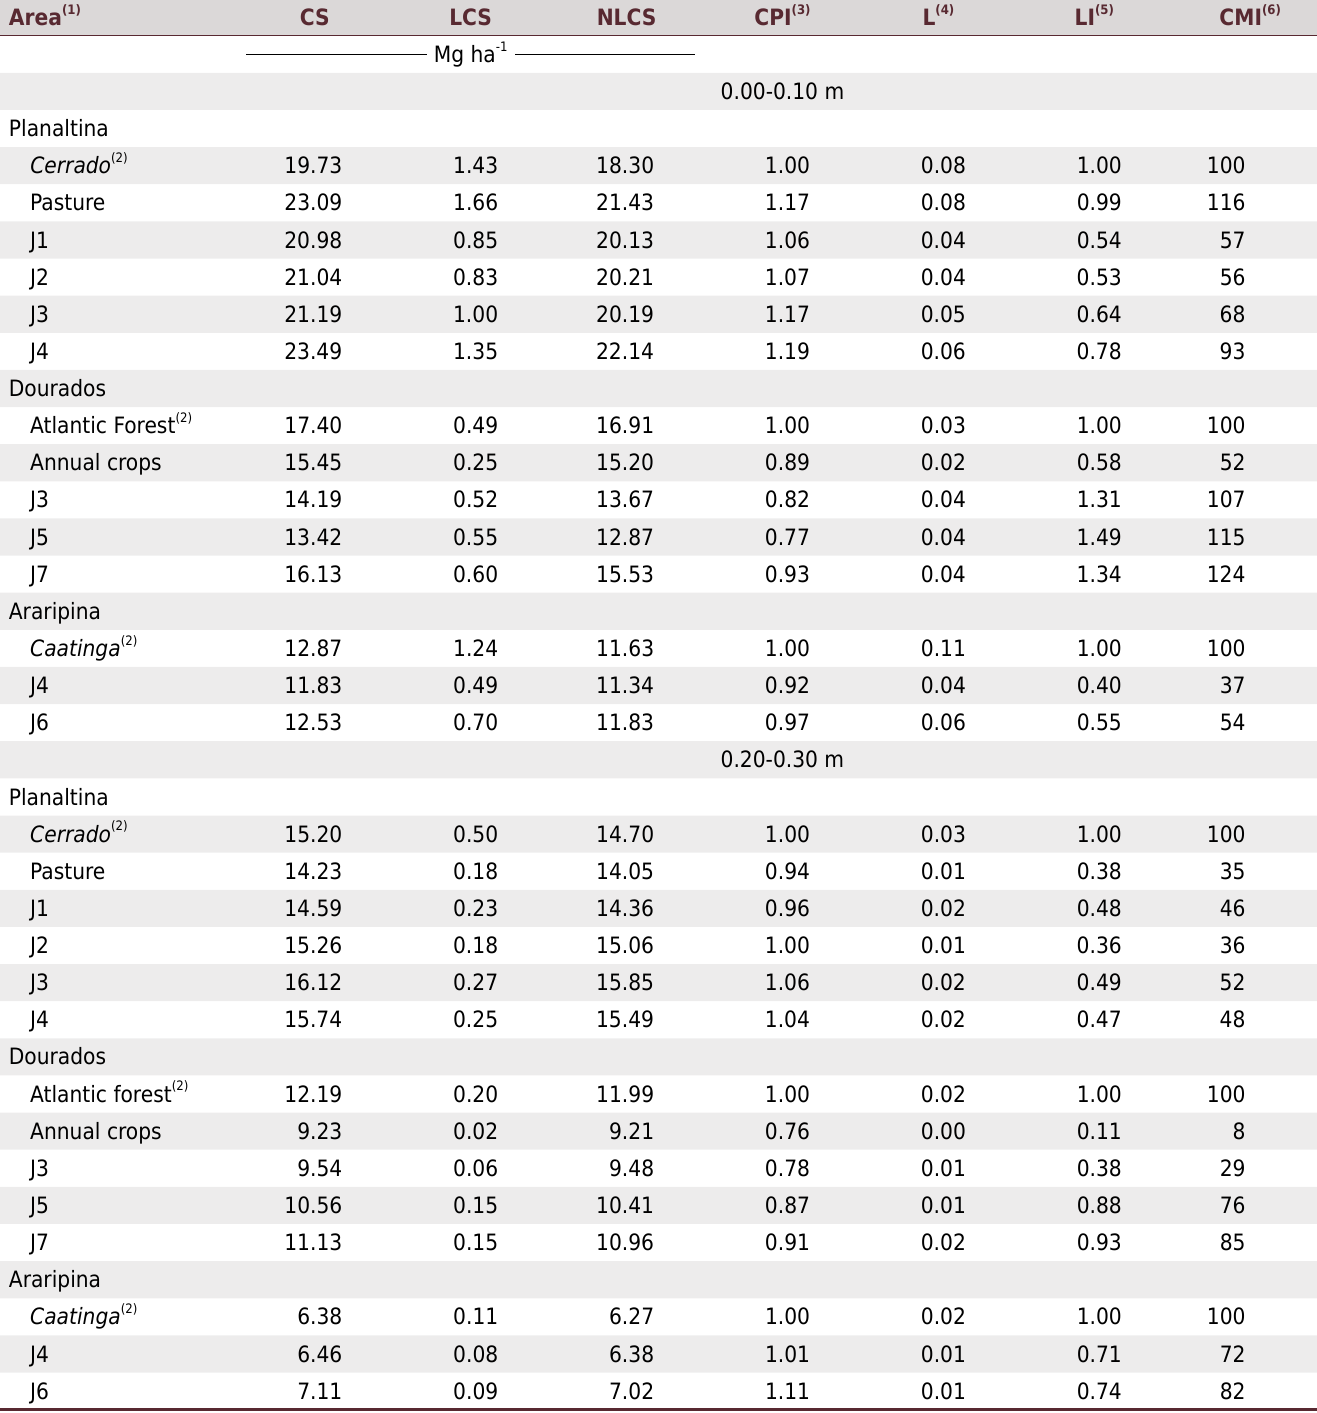
Table 2. Stocks of soil carbon (CS), labile carbon (LCS), and non-labile carbon (NLCS), carbon pool index (CPI), lability (L), lability index (LI), and carbon management index (CMI) at depths of 0.00-0.10 and 0.20-0.30 m in soils with different uses in Planaltina-DF, Dourados-MS, and Araripina-PE,